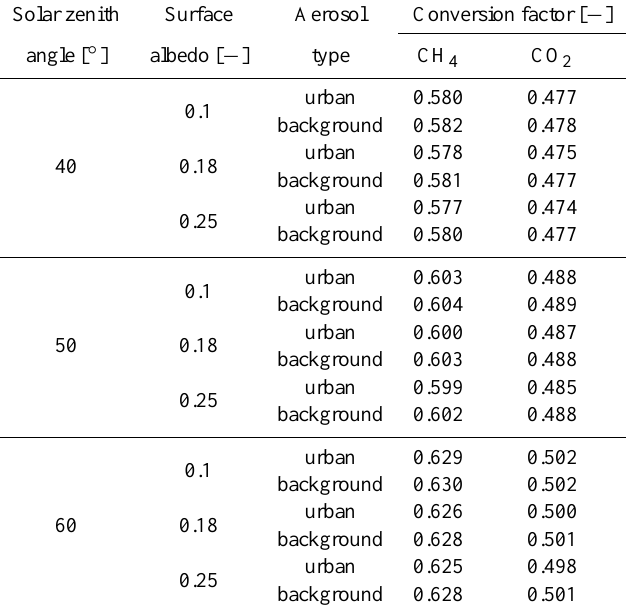
Table 1. Conversion factors for retrieval output (compare Sect. 3.2), assuming an aircraft altitude of 1.25km and that all deviations from standard mean column occurred below the